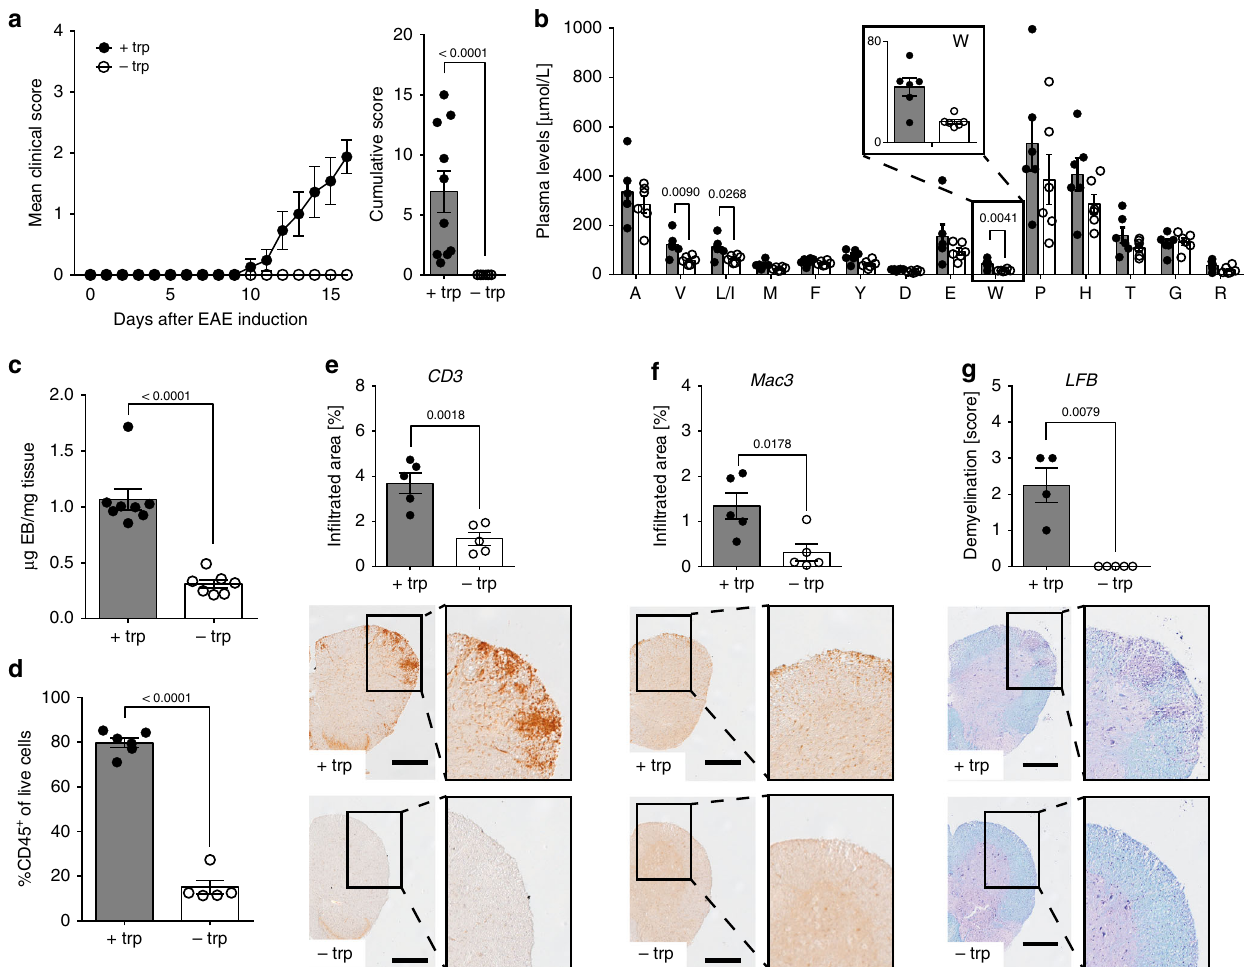
Fig. 2 DTR inhibits EAE. a Mean clinical EAE scores and cumulative scores ( + trp: n = 10; − trp, n = 10). b Plasma amino acid concentrations 16 days post- immunization ( n = 6). c Blood – brain barrier (BBB) disruption in spinal cord as assessed by Evan ’ s Blue (EB) on d15 post-immunization ( + trp: n = 8; − trp: n = 7). d Flow cytometric analysis of leukocyte in fi ltration into the spinal cord on d18 post-immunization ( + trp: n = 5; − trp: n = 6). Displayed as CD45 + cells of live single cells. e – g Spinal cord sections of EAE mice were stained for e T cells ( n = 5 vs. n = 5), f macrophages ( n = 5 vs. n = 5), and g demyelination ( n = 4 vs. n = 5). Scale bars: 250 μ m. Statistics: Mann – Whitney U -test for a , g unpaired two-tailed Student ’ s t -test for b – f . Each dot represents one individual mouse. Data are presented as mean ± SEM. Source data are provided as a Source Data fi